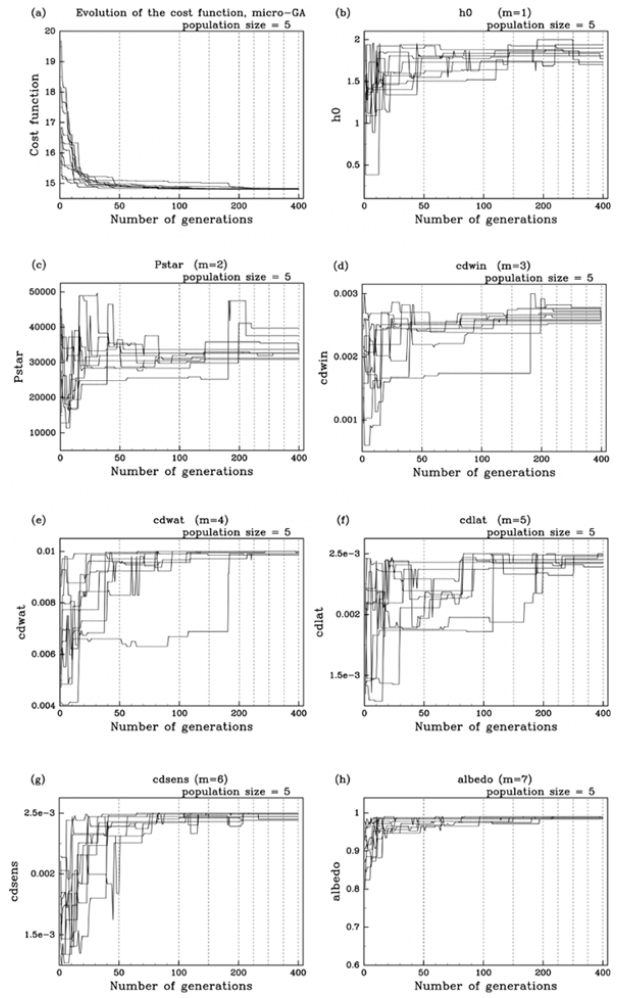
Fig. C1. Evolution of the cost function and associated parame- ter values through 10 independent optimization experiments by the µGA (µGA – 1: population size = 5, number of possibilities of each parameter = 2 7 ) : (a) evolution of the cost function, (b–h) evolu- tion of associated parameters (b) h 0 , (c) P ∗ , (d) cdwin , (e) cdwat , (f) cdlat , (g) cdsens and (h) albedo . Note that the division of the horizontal axes is nonlinear. The vertical dashed lines were plotted every 50